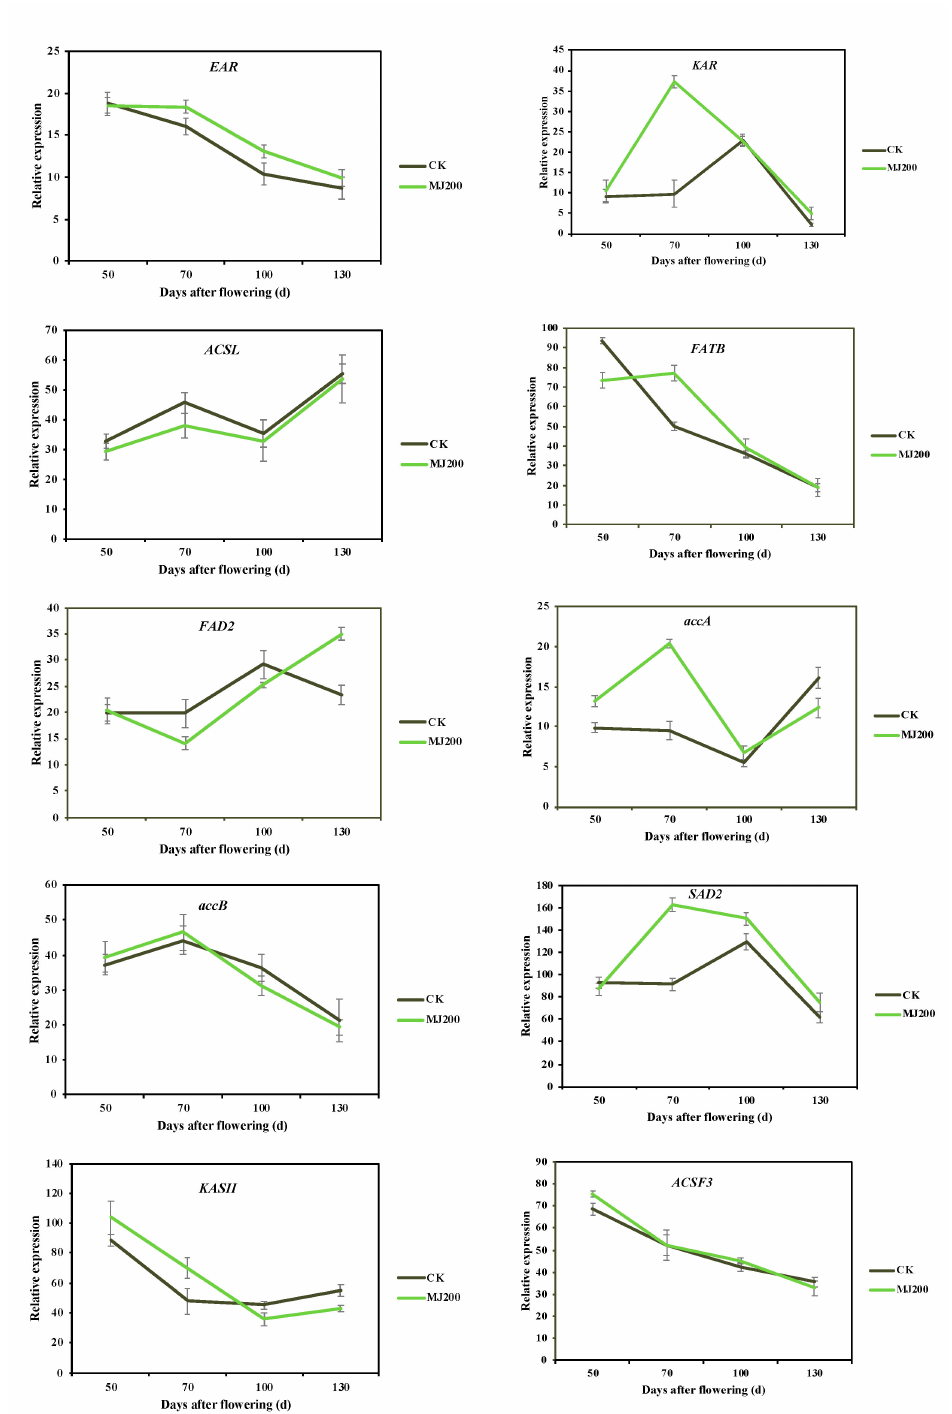
Figure 4. Effects of MJ200 on the expression of FA biosynthesis-related